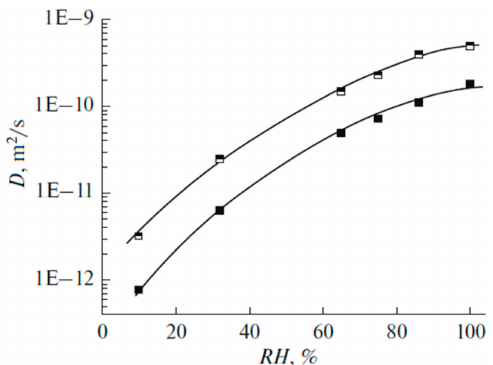
Figure 32. Diffusion coefficients of H + cations calculated from the proton conductivity data according to Equation 1.7 (lower curve) and the average diffusion coefficients of water molecules and H + cations measured by pulsed field gradient NMR (upper curve) in the H + form of the MSC membrane at different moisture contents. RH = 100%, the membrane is in contact with water. Reprinted with permission from [16]. Copyright 2020 Springer